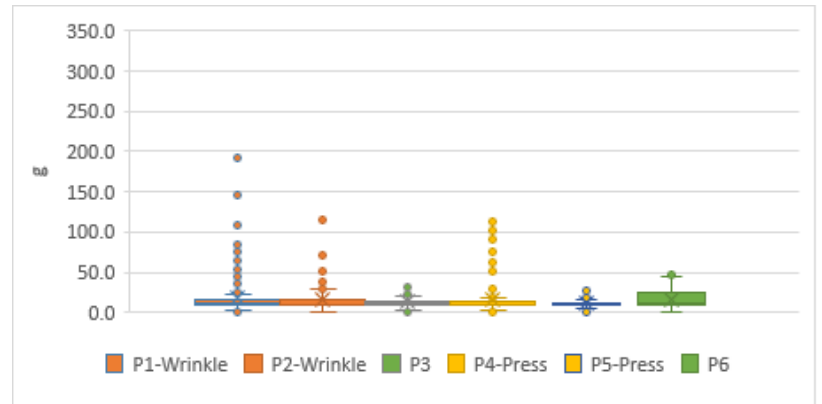
Figure 4. The pressure boxplot of a simulation test for a short arm swathed cast on a simulated arm. A total of 228 data points were collected from the short arm-cast splint. The average number of